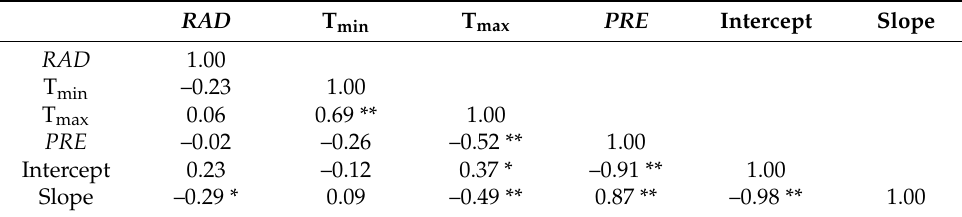
Table 8. Pearson’s correlation coefficients among weather data, slope, and intercept of regional equations in HLM. RAD T min T max PRE Intercept Slope RAD 1.00 T min –0.23 1.00 T max 0.06 0.69 ** 1.00 PRE –0.02 –0.26 –0.52 ** 1.00 Intercept 0.23 –0.12 0.37 * –0.91 ** 1.00 Slope –0.29 * 0.09 –0.49 ** 0.87 ** –0.98 **